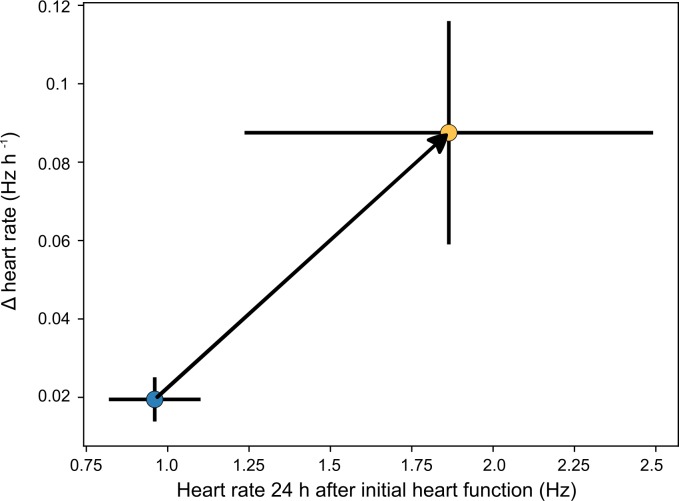
Early cardiac ontogenic response to elevated temperature in O. gammarellus(n = 8). Blue = 15°C, orange = 20°C (means ± 1 SD, S5 Data).